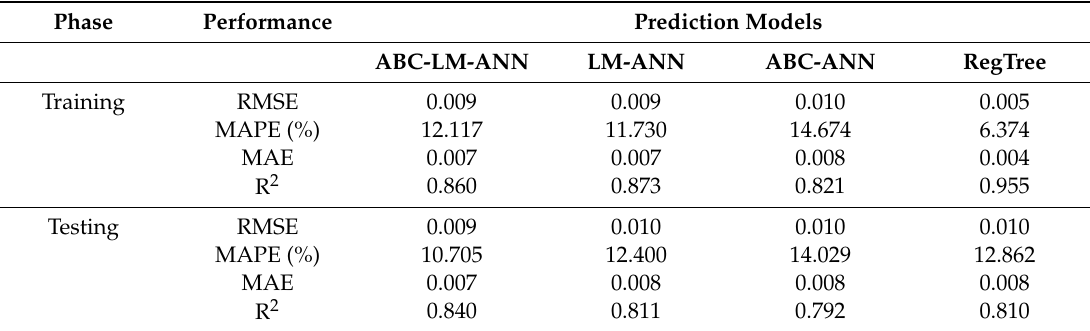
Table 3. Model result comparison.